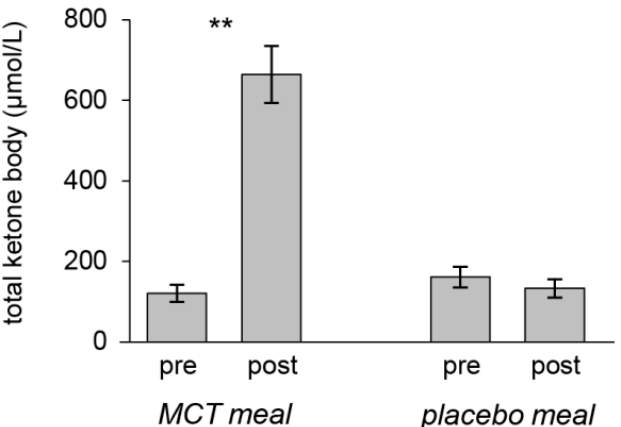
Figure 2. Mean plasma ketone bodies (acetoacetate plus β -hydroxy butyrate) at pre- and post-intake of the test meals. The MCT meal significantly elevated plasma ketone body levels. Error bars depict SEM; ** p <